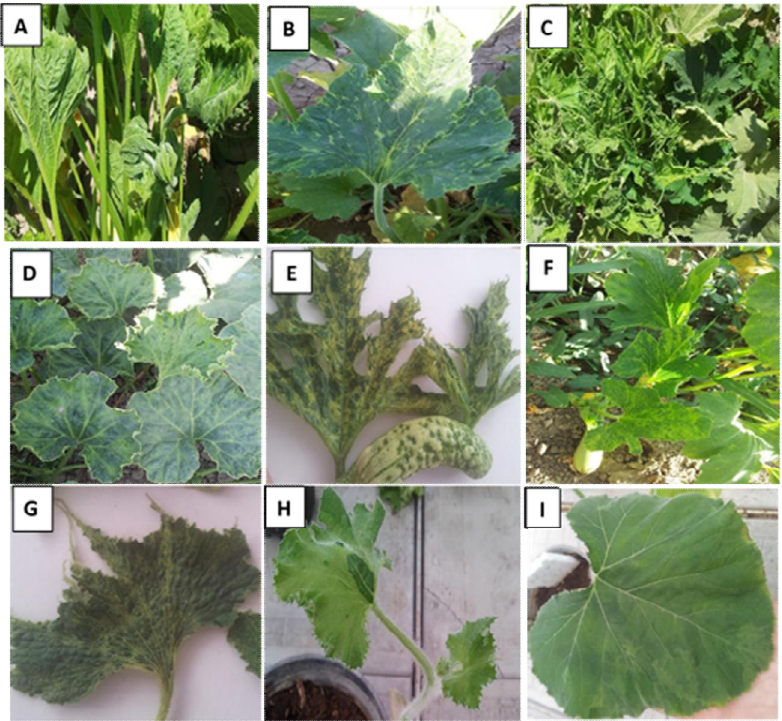
Fig. 1. Disease symptoms are caused by ZYMV and WMV on cucurbit crops. (A) upward leaf-rolling on Cucurbit a sp. caused by ZYMV (B) severe mosaic accompanied by chlorotic spots on Cucurbit a sp. caused by ZYMV (C) leaf narrowing on Cucurbit a sp. caused by ZYMV (D) mottling and vein clearing on Cucurbit a sp. caused by WMV (E) sever mosaic, chlorotic spots and blistering on cucumber leaves and fruit caused by WMV (F) chlorotic spots and twisted leaves on Cucurbit a sp. caused by WMV (G) leaf blister on Cucurbit a sp. 20 days post-inoculation (dpi) caused by ZYMV (H) dark green spot and leaf distortion on Cucurbit a sp. 15 dpi caused by WMV (I) mild mosaic on Cucurbit a sp. 20 dpi caused by ZYMV .